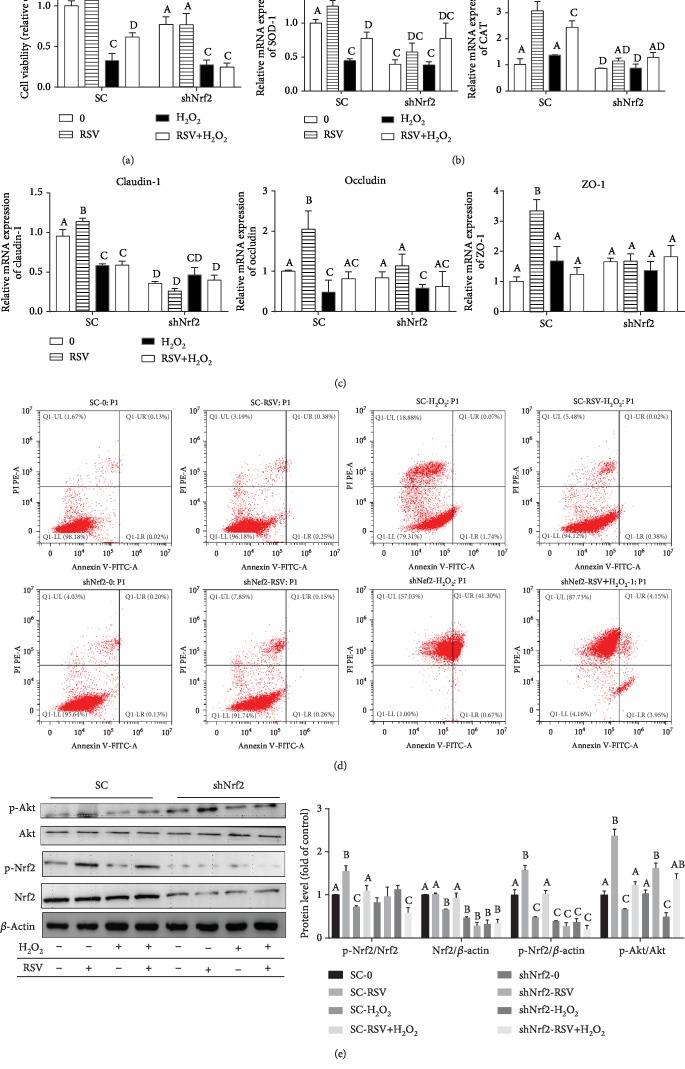
Effects of resveratrol on H2O2-induced cytotoxicity in Nrf2-knockdown IPEC-J2 cells. The Nrf2-knockdown (shNRF2-IPEC-J2) or control (SC-IPEC-J2) cells were pretreated with or without 50 μM RSV for 6 hours and then cocultured with 500 μM H2O2 for 4 hours. (a) Cell viability was measured using the CCK-8 assay. Results are presented as the percentage of cell viability compared with the control (0 μM). (b, c) The relative expression of SOD-1, CAT, claudin-1, occludin, and ZO-1 was detected by qRT-PCR. Data are shown as ratios of abundance of target gene transcripts in the treated cells to those in the control cells after normalization to β-actin. (d) Apoptotic cells were analyzed by flow cytometry using Annexin V-PI double staining. (e) Protein levels of Nrf2, Akt, p-Nrf2, and p-Akt were detected by Western blot with β-actin as the loading control. Values are the mean ± SE. The columns with the same superscript capital letters and with different superscript capital letters mean no significant difference (P > 0.05) and significant difference (P < 0.05), respectively.